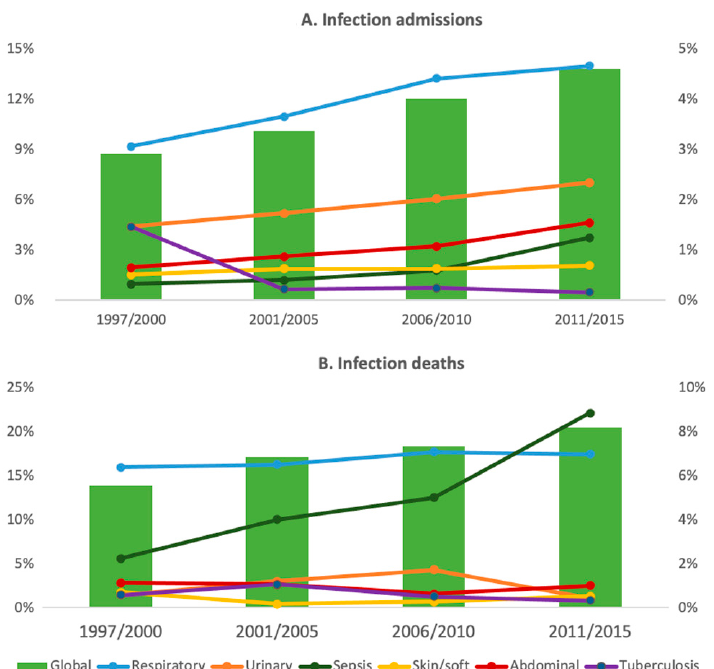
Figure 2. Infectious disease admissions and deaths. The figure shows the trends in admissions ( A ) and deaths ( B ) because of infection. Data are expressed as a percentage of total admissions and deaths for the overall infections (left ordered axis) and for the subgroups that comprise infectious disease (right ordered axis). disease (right ordered axis).